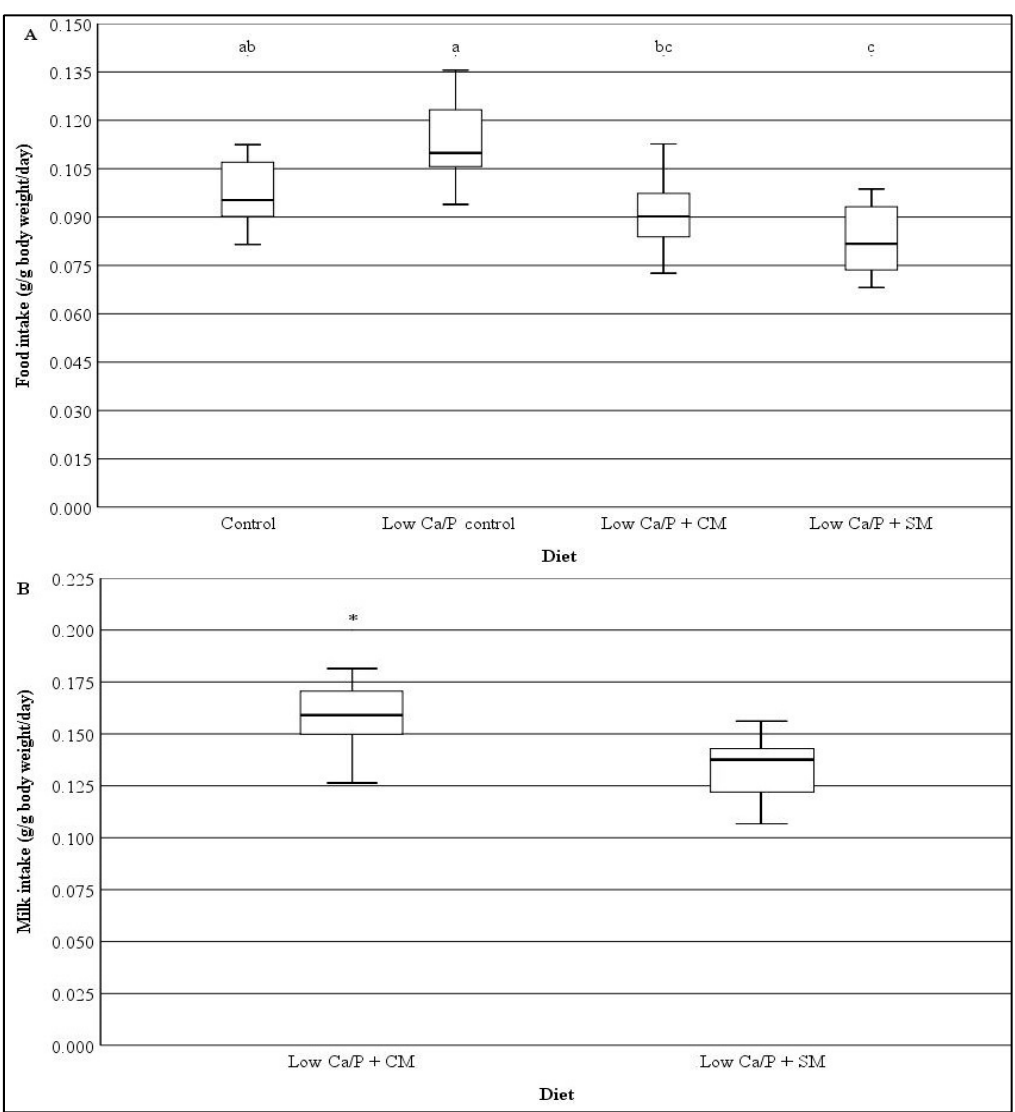
Figure 1. Diet intake of rats fed on different milk diets (mean ± standard deviation): (A) Food intake (g/g body weight/day) and (B) Milk intake (g/g body weight/day). Control = rats fed a modified-AIN-93M diet ( n = 9), Low Ca/P control = rats fed a Low Ca/P Modified-AIN-39M diet ( n = 9), Low Ca/P + CM = rats fed a modified-AIN-93M diet with the addition of cow milk ad libitum instead of drinking water ( n = 15), Low Ca/P + SM = rats fed a Low Ca/P modified-AIN-93M diet with the addition of sheep milk ad libitum instead of drinking water ( n = 15). Different superscript letters indicate significant differences between dietary groups with respect to food intake, determined using repeated measures ANOVA and Tukey’s post hoc testing ( p < 0.001). * indicates a significant difference between the different diets with respect to milk intake, determined using repeated measures ANOVA ( p = 0.001).